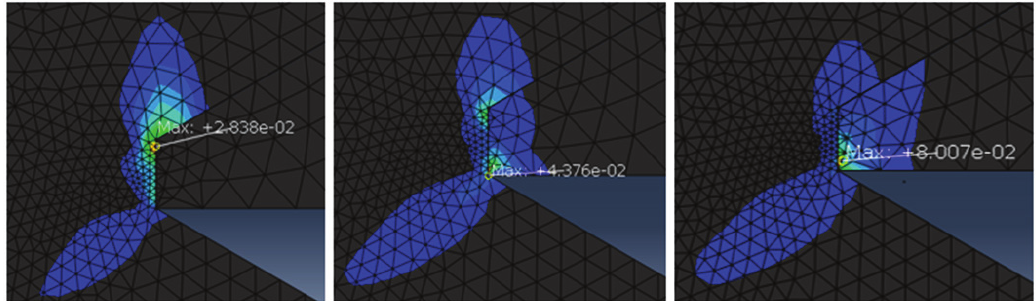
Figure 14. Maximum plastic strain in elastic–plastic simulations with the friction coefficient values of ( a ) 0.05, ( b ) 0.3, and ( c ) 0.6 .